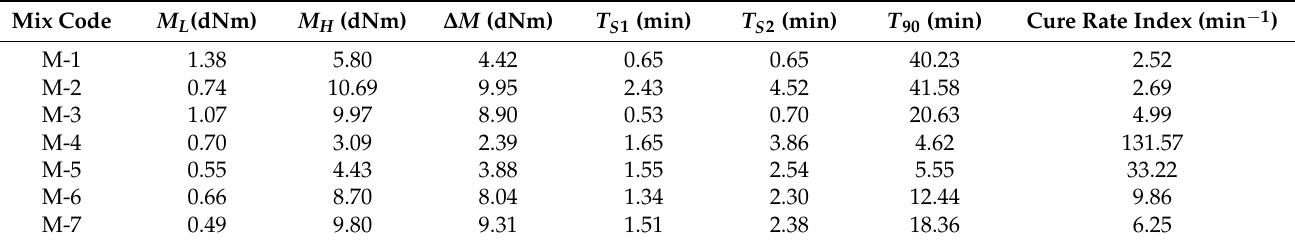
Figure 2. Cure curves of the mixes M-1, M-2, and M-3. Table 2. Rheometer cure data of the mixes at 180 ◦ C, 1